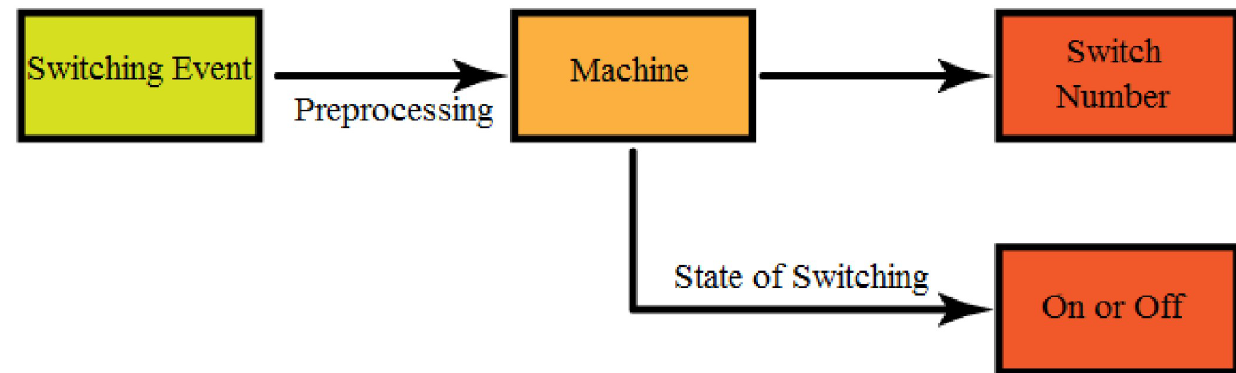
Fig 8. Machine Learning (ML) process. The methodology of topology identification.